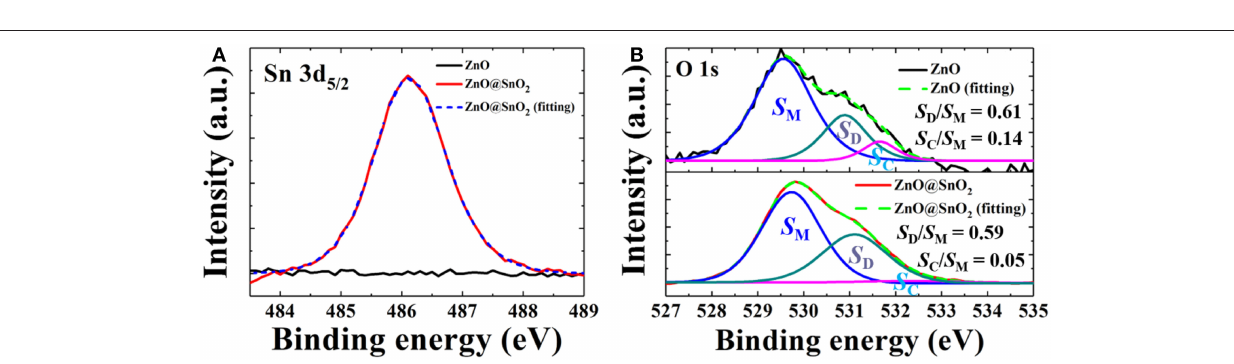
CQDs is 1.25 eV (first exciton absorption peak is at 979 nm) (see Figure S2 ). Secondly, the valence band maximum (VBM) of ZnO NWs, ZnO@SnO 2 NWs, and PbS CQDs was measured